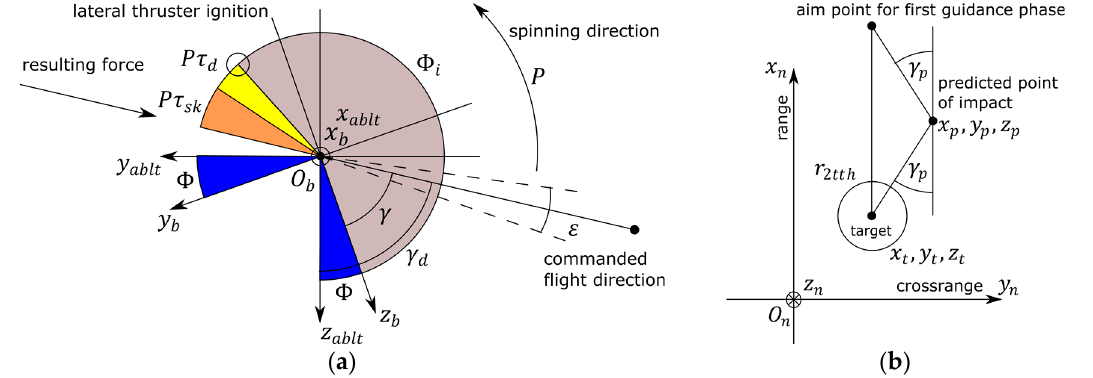
6 of 26 Figure 3 . The concept of predictive guidance. Zero-effort miss distance is calculated and used to achieve the target. The magnitude of the thruster force is constant for each of the motors, so the only possibility is to use pulse frequency modulation. A set of conditions for firing the single thruster was formulated as below [8,28, 49]: •